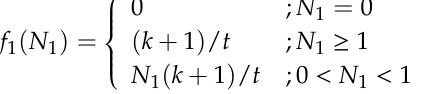
Figure 2. A simple example for analytical model investigation by using APL2—( a ) program code, ( b ) model execution, ( c ) results interpretation.